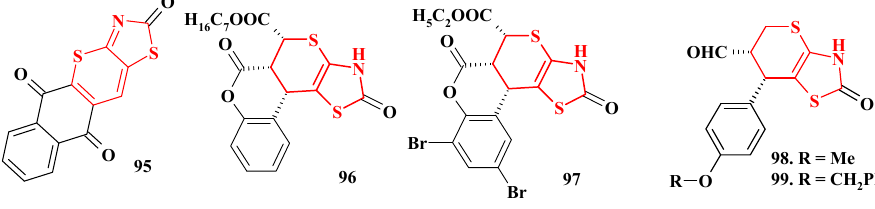
Figure 4. Thiopyrano[2,3- d ]thiazoles with antiviral activity.